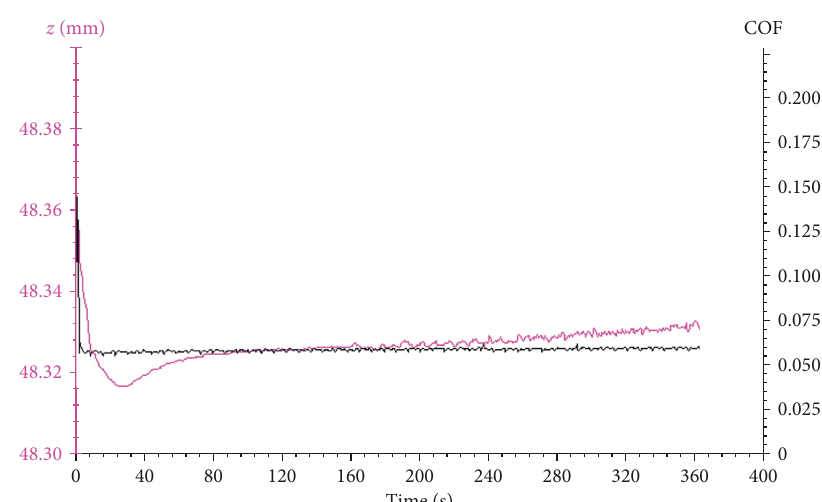
Figure 12: The change of friction coefficient and z -axis displacement (2Hz, 3N, and albumin solution).